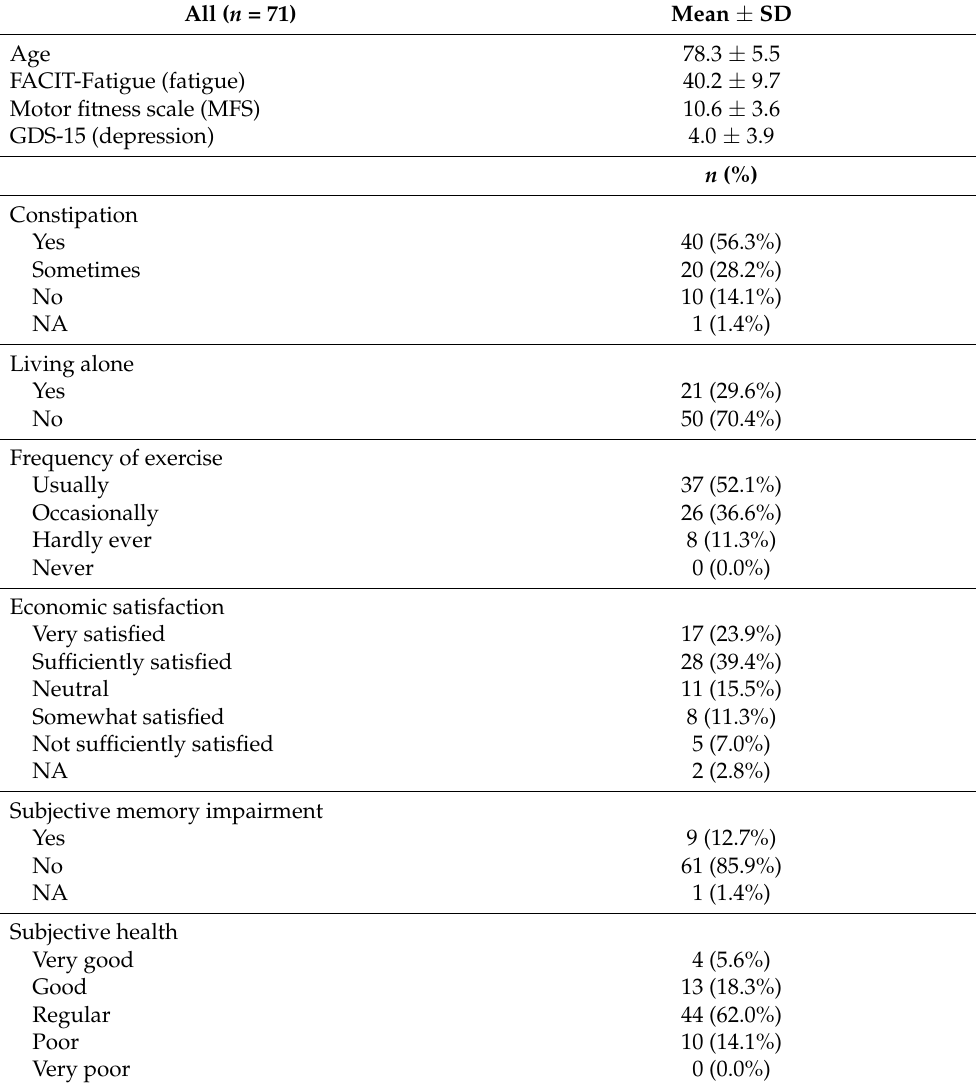
Table 1. Characteristics of